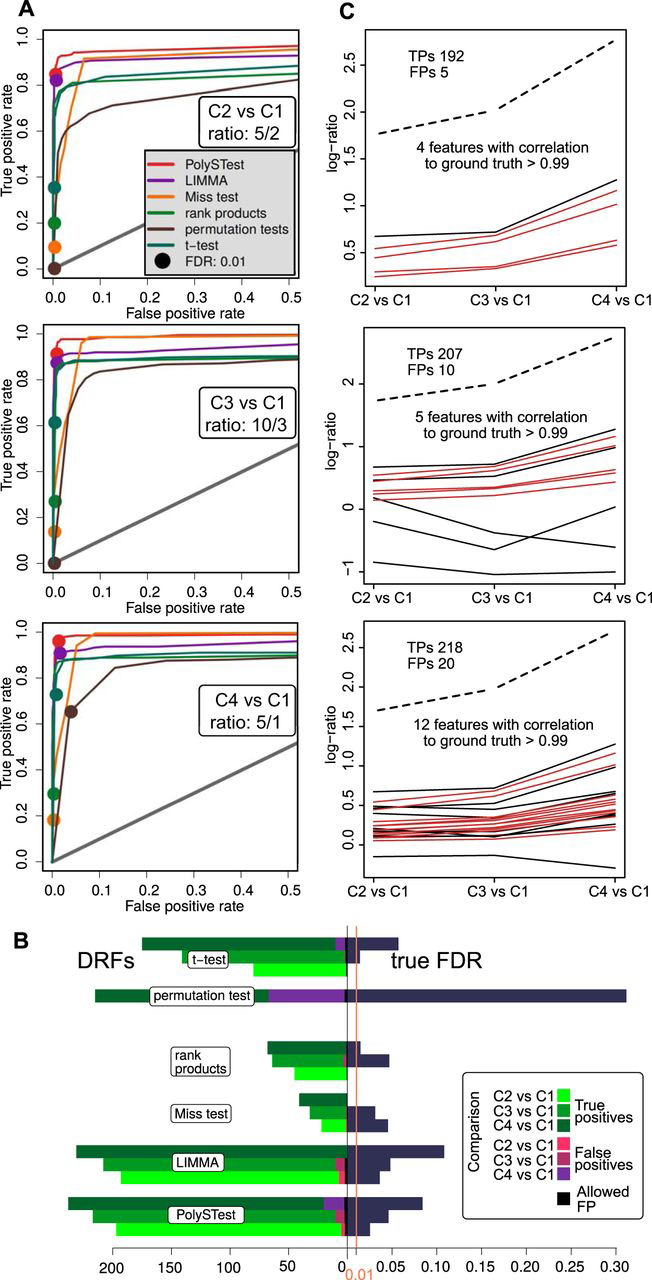
PolySTest outperforms individual tests for the 2-species data set as Miss test adds significant proteins.A, ROC curves show that combined tests, mostly supplied by the Miss test, considerably increase the true positive rate. Filled circles correspond to an FDR of 0.01. B, Comparison of test performance on basis of sensitivity and confidence (FDR: 0.01). C, Higher concentrations of E. coli proteins in mixture leads to more false positives which however follow the trend of the mixture as confirmed by high correlations to the given ratios. The dashed line corresponds to the averaged log-ratios of all E. coli proteins. Red lines are proteins with correlation > 0.99.